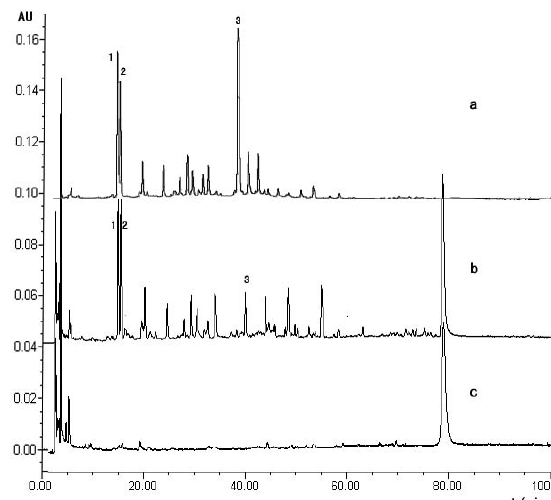
Figure 2. Plasma metabolite HPLC profiles of Yuan zhi